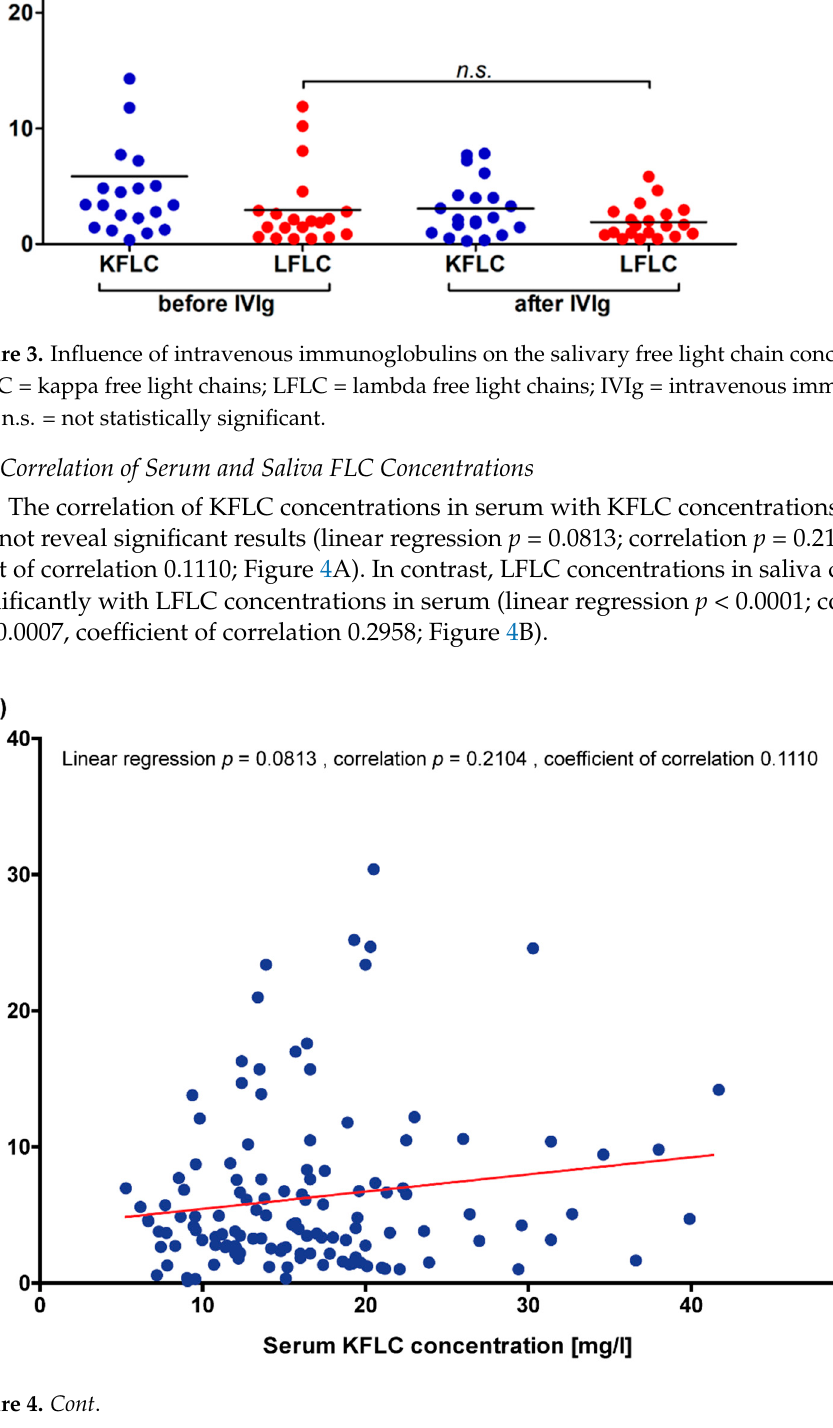
Figure 4. Correlation of the serum and saliva free light chain concentrations. ( A ) KFLC = kappa free light chains; ( B ) LFLC = lambda free light chains. 3.7. Correlation of Saliva FLC Concentrations with Renal Function No statistically significant results were found when correlating renal function esti ‐ mated from eGFR according to the CKD ‐ EPI creatinine equation in ml/min/1.73m 2 with salivary KFLC and LFLC concentrations ( p ‐ values for linear regression and a correlation between 0.1553 and 0.7927).